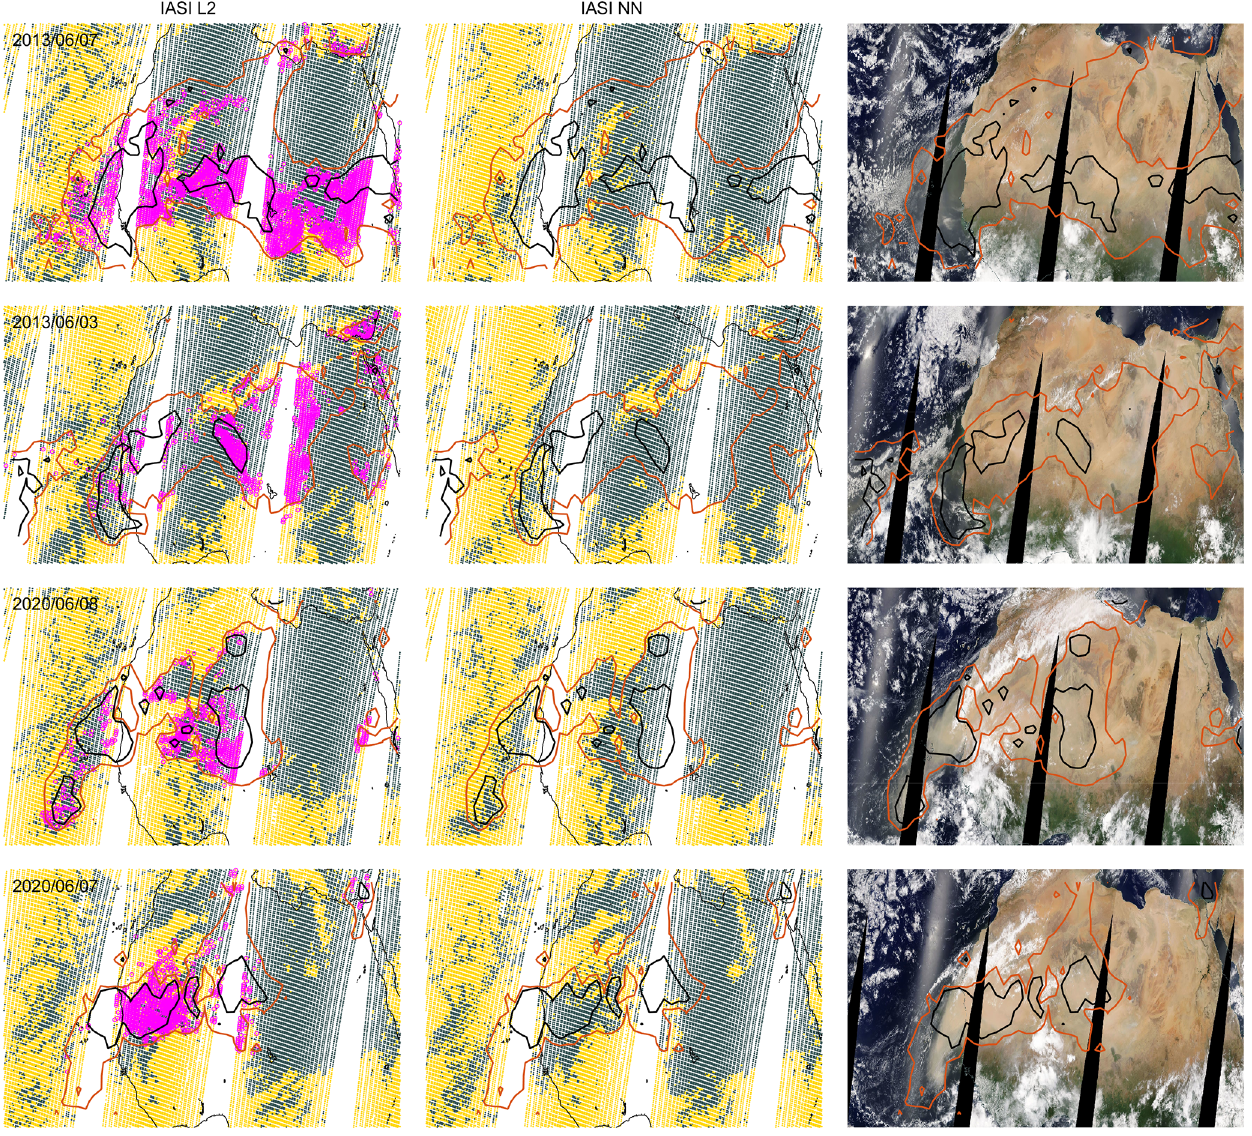
Figure 7. Cloud detection over north-western Africa from the EUMETSAT IASI-L2 cloud product (left column) and the IASI-NN detection algorithm (middle column) for 4d (13 February, 24 February, 17 June, 18 June 2020, morning orbits) affected by dust plumes. Yellow and blue circles refer to cloudy and cloud-free scenes, respectively. The right column shows the MODIS (Terra)-corrected reflectance (true colours) imagery for the corresponding days (from NASA Worldview). The contours represent two levels of dust index (10 red and 20 black). The pink circles on the IASI L2 maps show the pixels flagged as cloudy by the L2 and cloud-free by the NN in the presence of high dust loads (cloud index >